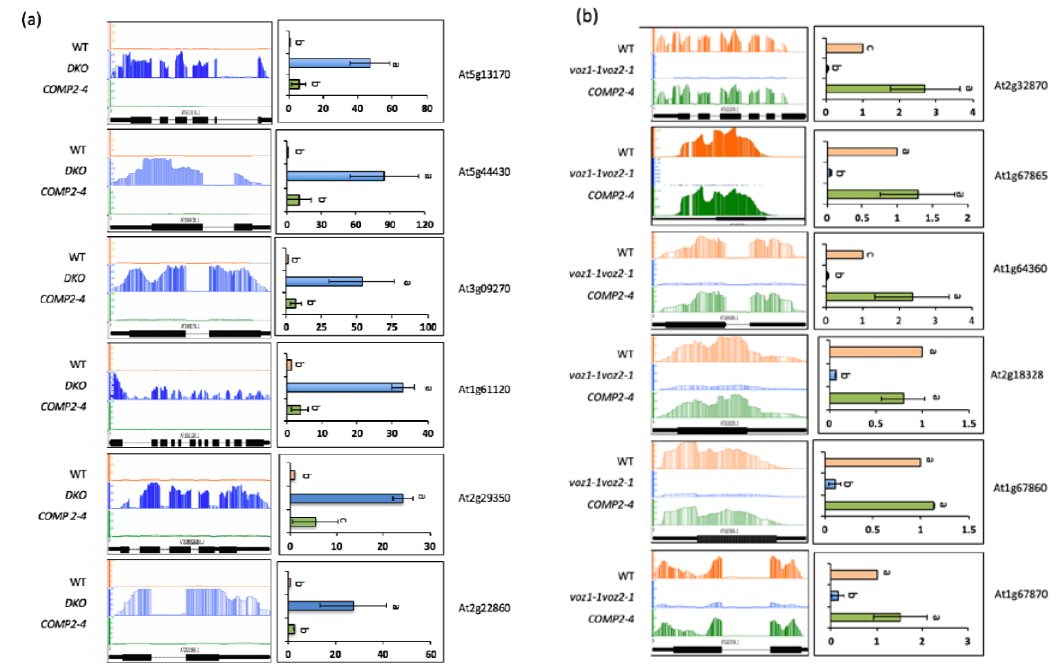
Figure 3. Validation of up- and down-regulated genes in DKO . ( a ) RT-qPCR validation of randomly selected up-regulated genes. ( b ) RT-qPCR of randomly selected down-regulated genes. Left panels in ( a , b ) show relative sequence read abundance (Integrated Genome Browser view) as histograms in WT, DKO (voz1-1 voz2-1) and COMP2-4 lines. The Y-axis indicates read depth with the same scale for all three lines. The gene structure is shown below the read depth profile. The lines represent introns and the boxes represent exons. The thinner boxes represent 5 (cid:48) and 3 (cid:48) UTRs. Right panels in ( a , b ) show fold change in expression level relative to WT. WT values were considered as 1. Student’s t -test was performed and significant differences ( p < 0.05) among samples are labeled with different letters. The error bars represent SD. The genes that were randomly picked include At1g61120 (terpene synthase 4), At1g64360 (enescence-associated and QQS-related), At1g67860 (hypothetical protein), At1g67865 (hypothetical protein), At1g67870 (hypothetical protein), At2g18328 (RAD-like4), At2g22860 (phytosulfokine 2 Precursor), At2g29350 (senescence-associated gene 13), At3g09270 (glutathione S-transferase TAU8), At2g32870 (TRAF-like protein), At5g13170 (senescence-associated gene29), and At5g44430 (plant defensing